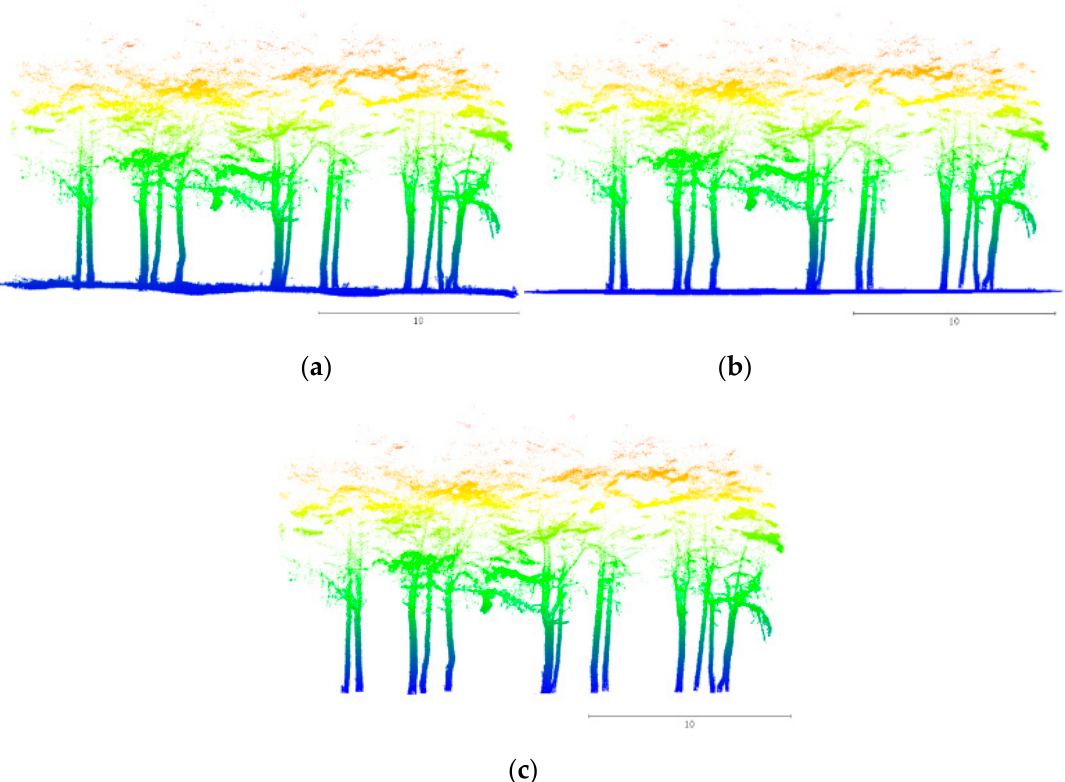
Figure 2. HMLS point cloud preprocessing. ( a ) Original point cloud; ( b ) Normalized point cloud; ( c ) Point cloud after removing ground points.